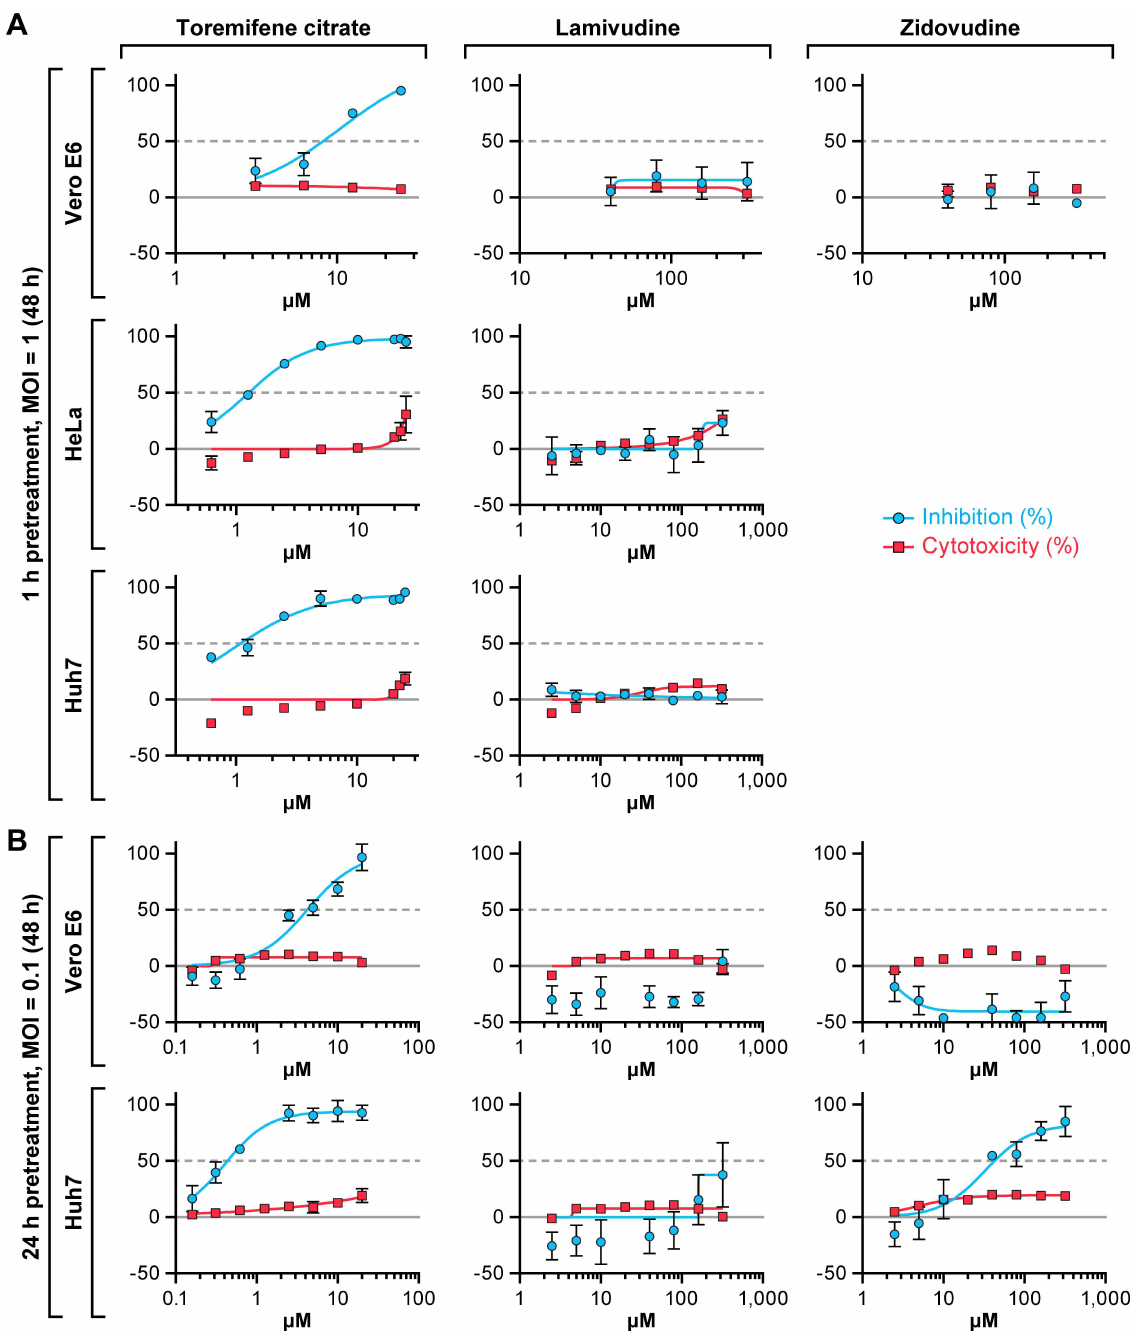
Fig 2. Antiviral activity against Makona variant of Ebola virus at an MOI of 1 or 0.1. (A) Vero E6, HeLa, or Huh 7 cells were treated with toremifene citrate, lamivudine, or zidovudine for 1 h. Then cells were infected with EBOV/Mak at a multiplicityof infection(MOI) of 1 for 48 h. (B) Vero E6 or Huh 7 cells were treated with toremifene citrate, lamivudine, or zidovudine for 24 h. Then cells were infected with EBOV/Mak at a multiplicityof infection(MOI) of 0.1 for 72 h. Toremifene citrate was used as a positive control. Antiviral activity is shown in blue and cytotoxicity is shown in red. The experiment was run on duplicateplates with triplicate wells per dose (mean ± SD; n = 3). Representative graphs from 1 to 6 independentexperiments are